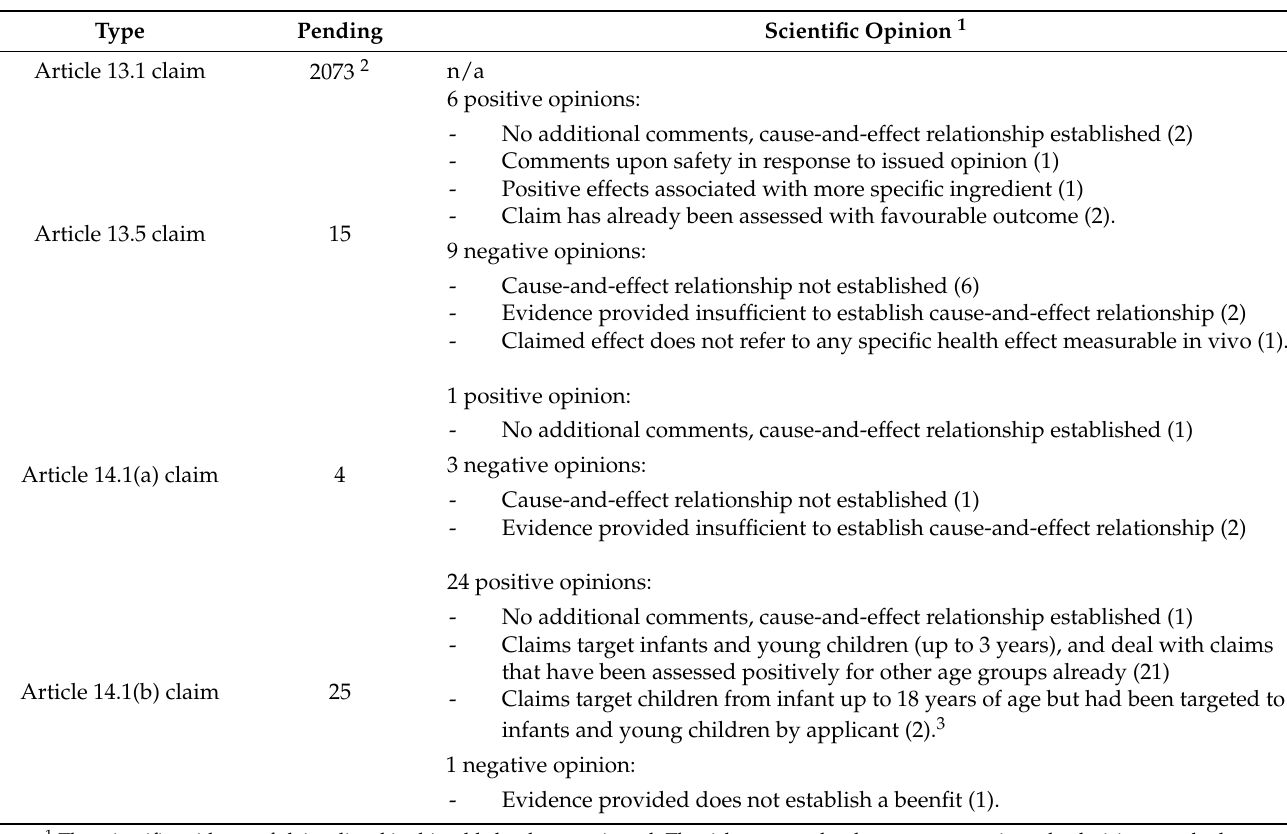
Table 2. Health claims pending risk management